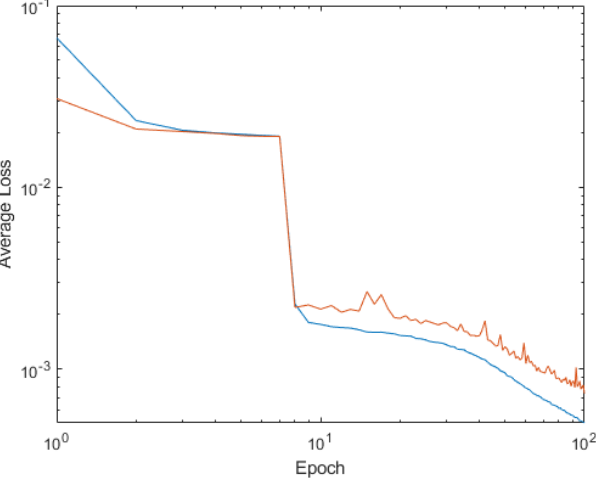
Figure 5. Average loss on training patterns in blue and validation patterns in orange for the Dy- namic drop-out SGD of Mexican Hat.